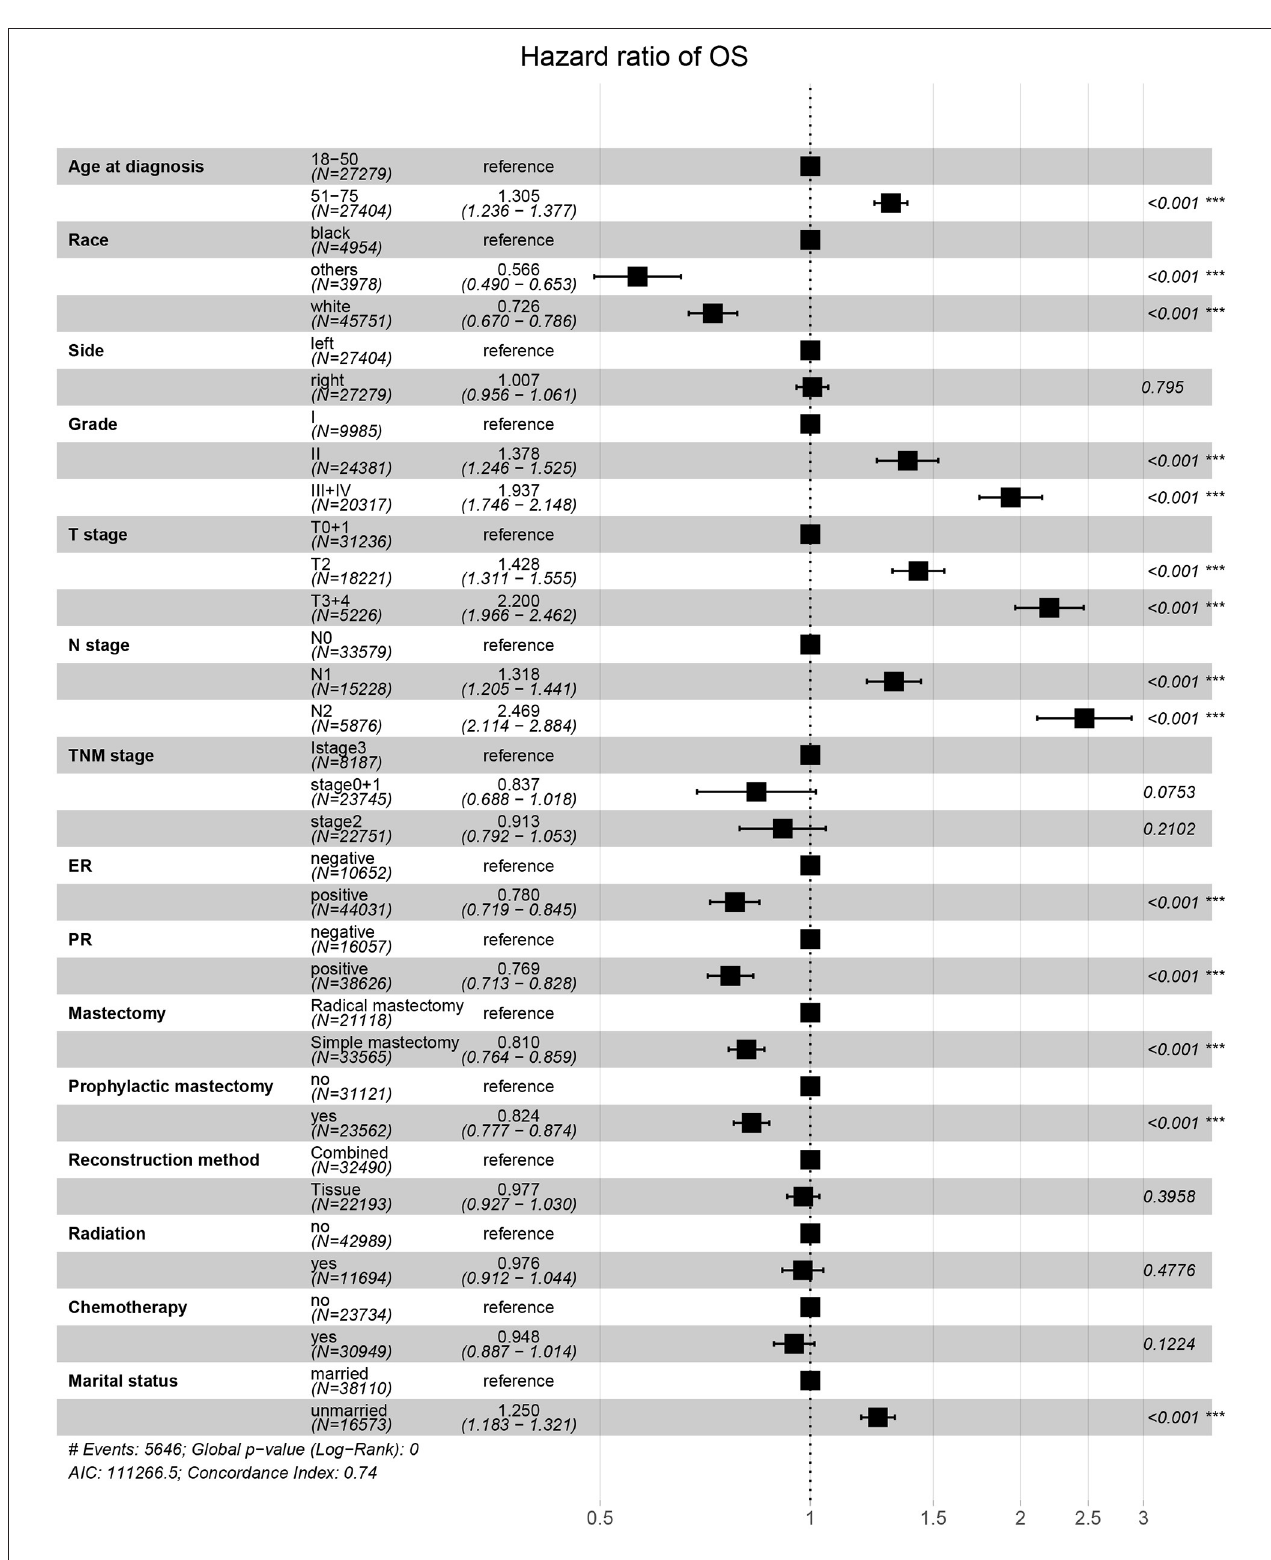
FIGURE 3 | Forest